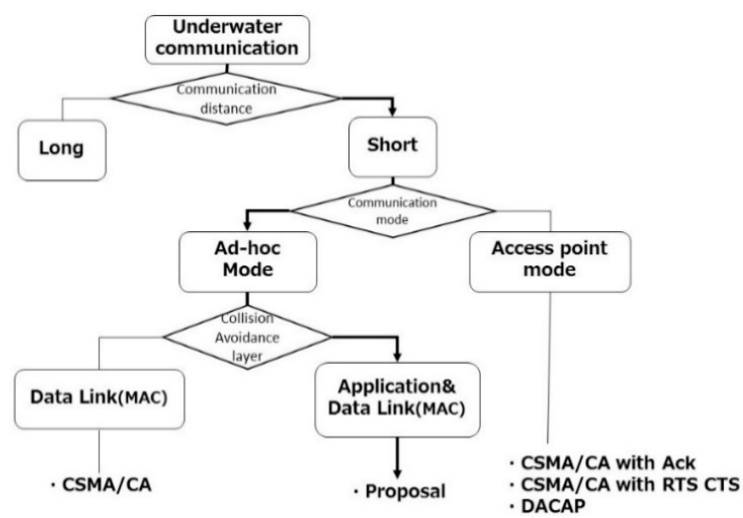
Figure 1. Position of the proposed transmission medium multi-access contention avoidance technology.